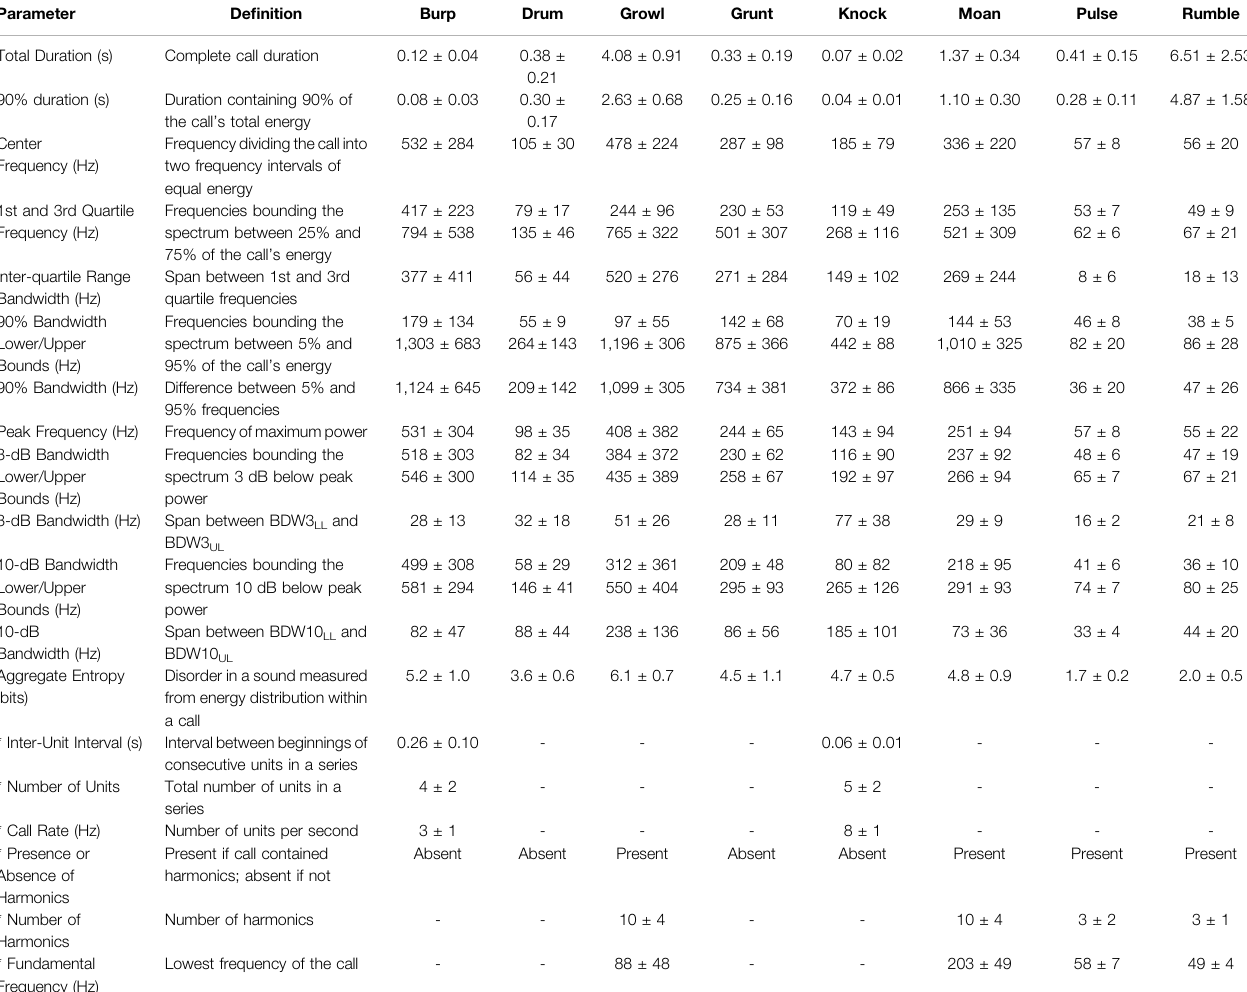
TABLE 1 | Mean (±SD) values of acoustic parameters measured for eight call types produced under water by two male spotted seals. Only high-quality calls with SNR > 10 dBwereanalyzed( n =20percalltype).Allparametersweremeasured withRavenPro1.5software (Hannwindow; DFTsize4,096or8,192samplesdependingon samplingrate(85.5 ms);90%overlap;3-dB fi lterbandwidth16.9 Hz).Asterisks(*)denotecallvariablesthatwereeitherdiscreteorthosethatweremeasuredonlyforcertain call types; these parameters were used to describe vocalizations but were not used in the DFA to validate call